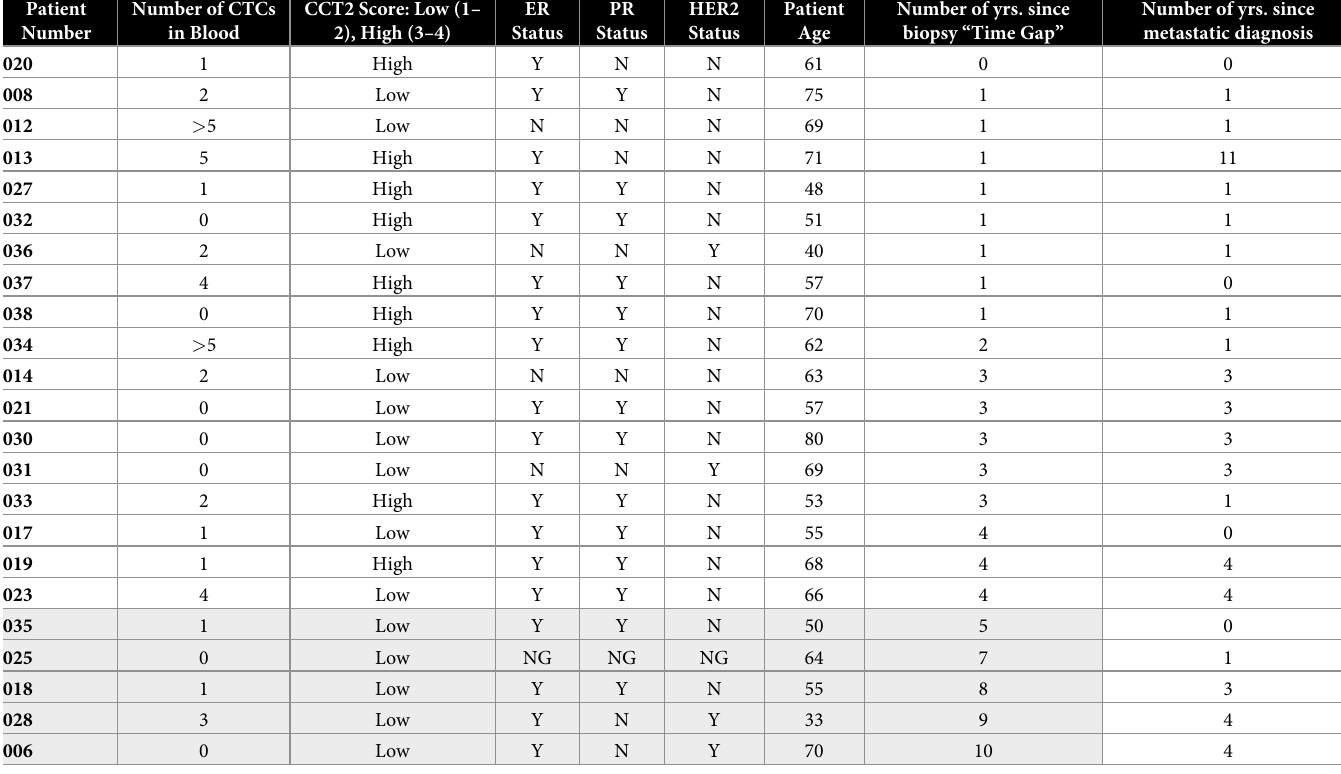
Table 1. Analysis of different prognostic markers from metastatic breast cancer (MBC)